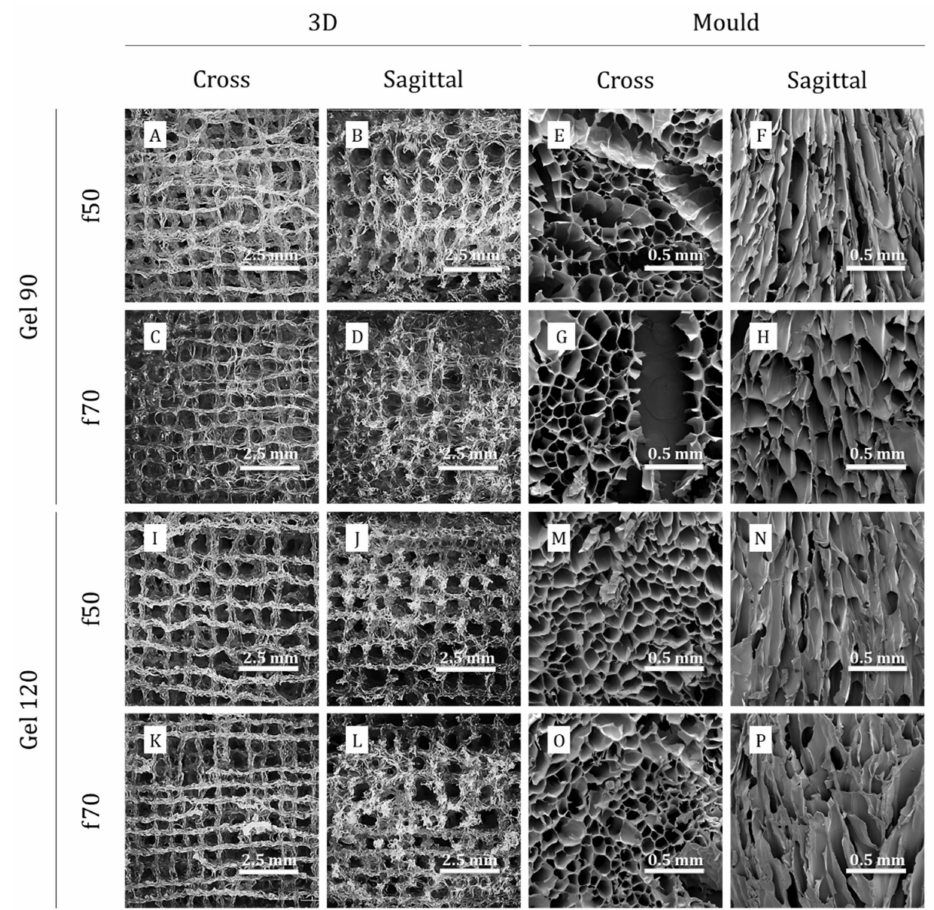
Figure 3. Cross and sagittal section of 3D printed and mould-casted scaffolds, after freeze casting, respectively, acquired by optical microscope and ESEM. ( A – D , I – L ) morphology of 3D printed scaf- folds acquired by optical microscope; ( E – H , M – P ) morphology of mould casted scaffolds acquired by